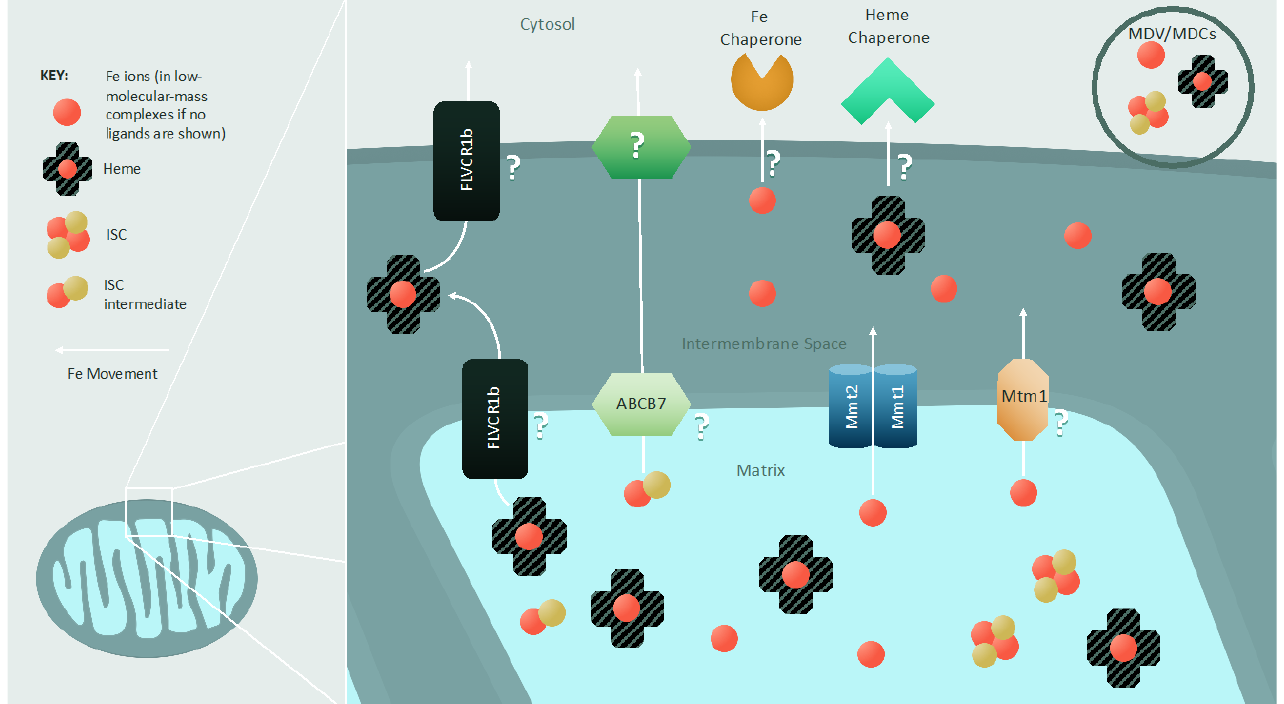
Figure 3. Export of mitochondrial iron and iron-containing cofactors: Iron is exported from mitochondria as heme or metal ions in low-molecular-mass complexes. Additionally, a presently unidentified intermediate required for cytosolic ISC biogenesis is also exported from mitochondria. In yeast, three inner mitochondrial membrane iron exporters have been identified: Mmt1, Mmt2, and Mtm1. In the case of heme export, FLVCR1b is postulated to play a role, but it is unclear where FLVCR1b localizes within the mitochondrion or to what extent it facilitates heme export. The ISC intermediate necessary for cytosolic ISC biogenesis is trafficked across the inner mitochondrial membrane by Atm1 in yeast and ABCB7 in mammals. Methods of export across the outer mitochondrial membrane remain unknown. It is hypothesized that various protein channels allow for the flow of these iron species, and that iron and cofactor chaperones directly accept or extract their cargo from the mitochondrion. A non-protein-based mechanism for iron, heme, and ISC intermediate export is also possible via mitochondria-derived vesicles (MDVs) and compartments (MDCs).